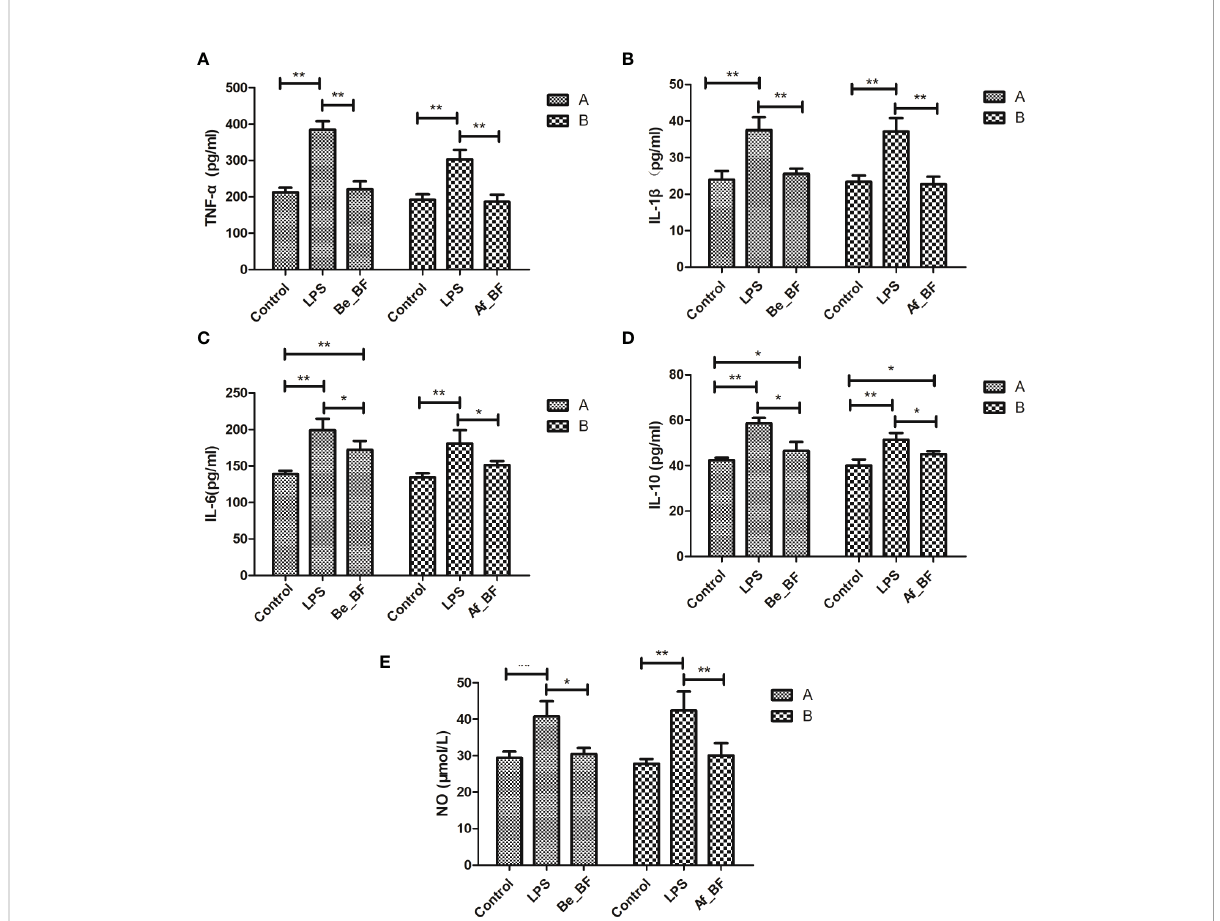
FIGURE 6 Effects of B . fragilis on the release of in fl ammatory cytokine levels in different groups. (A) TNF- a , tumor necrosis factor; (B) IL-1 b , interleukin-1 b ; (C) IL-6, interleukin-6; (D) IL-10, interleukin-10; (E) , nitric oxide; LPS, LPS-treated group; Be_BF, B . fragilis treatment before injection of LPS; Af_BF, B . fragilis treatment after injection of LPS. * p < 0.05; ** p <